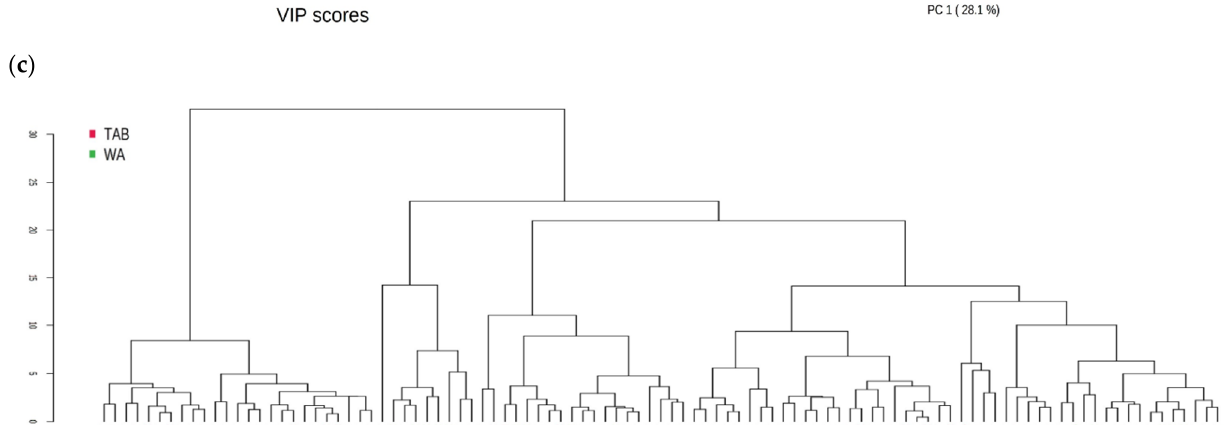
Figure 8. ( a ) Score plot of PLS-DA analysis of percentage greenness at maturity (GM) and grain yield (GY) of the 46 and 52 stay-green introgression lines and their parents ‘Tabat’ (TAB) and ‘Wad Ahmed’ (WA), respectively, under irrigated (W1) and drought (W2) at Khartoum North, and rainfed at South Gedaref (SG), North Gedaref (NG) and El Obaied (OB). Blue dots represent the TAB group, and red dots represent the WA group. PCA ( b ) and dendrogram ( c ) analysis of the 46 and 52 stay-green introgression lines and their parents.